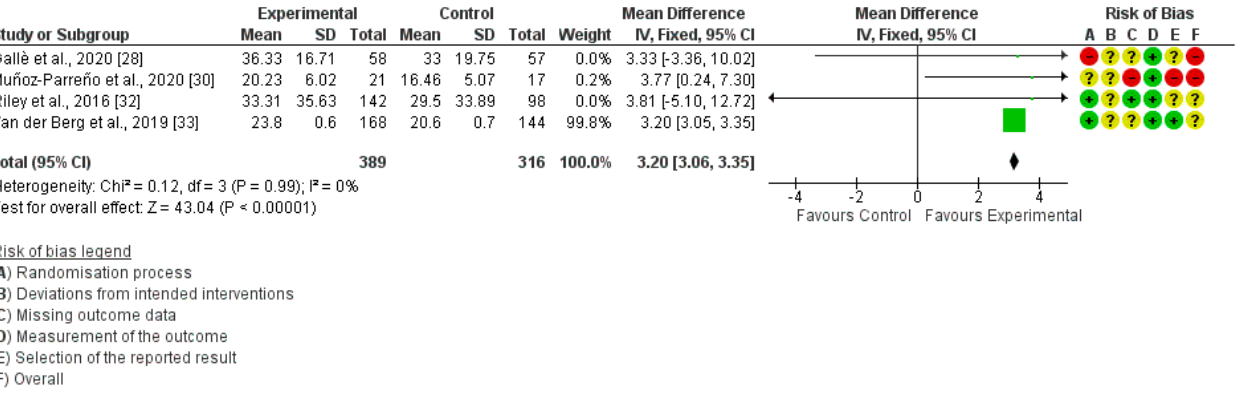
Figure 4. Forest plot of in − school MVPA .